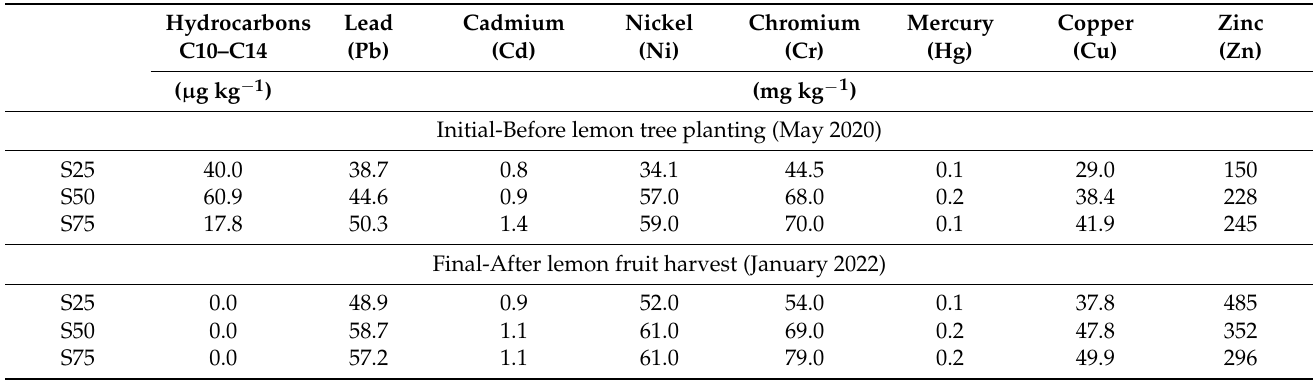
Table 2. Initial characterization (before planting, May 2020) and final characterization (after harvesting the lemons, January 2022) of the culture media used in this